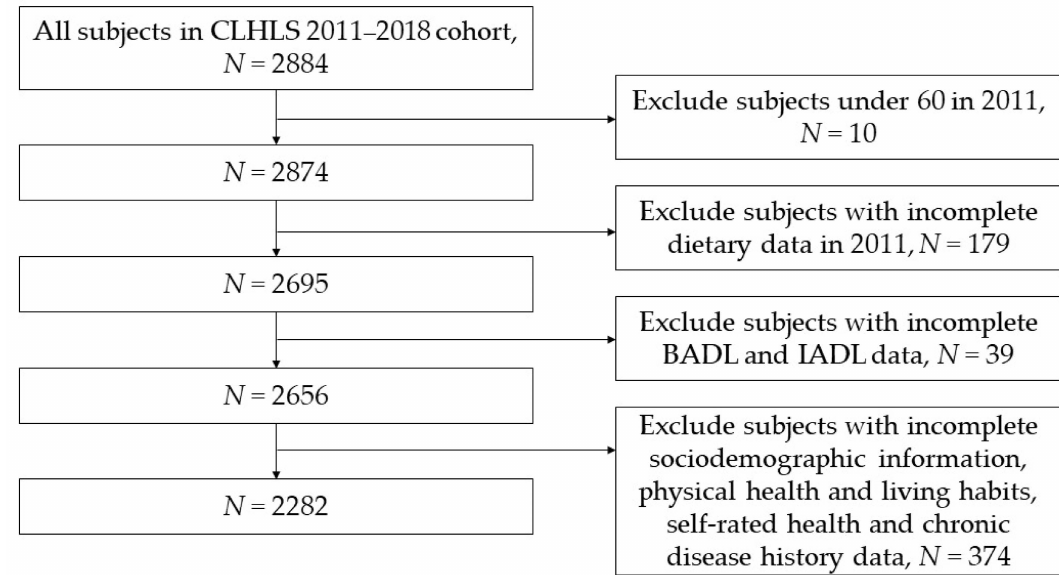
Figure 1. Flow chart for inclusion and exclusion of research